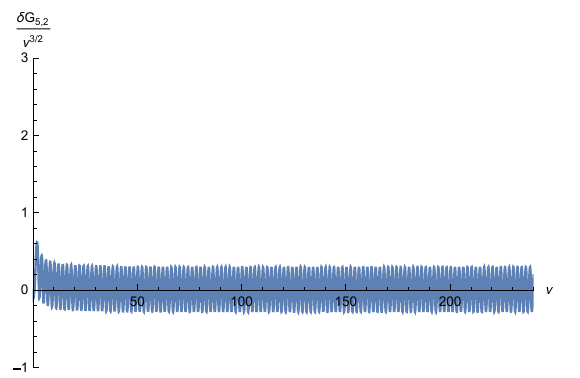
Figure 5 . Error estimate for G J =0 for GFF as a function of (cid:23) . Parameters are chosen to be d = 3, 5 ; 2 J = 0, (cid:14) (cid:30) = 5 . We consider the di(cid:11)erence between the l.h.s. and the r.h.s. in (6.3) which we also 8 p multiply by (cid:23) . We see that the result agrees with